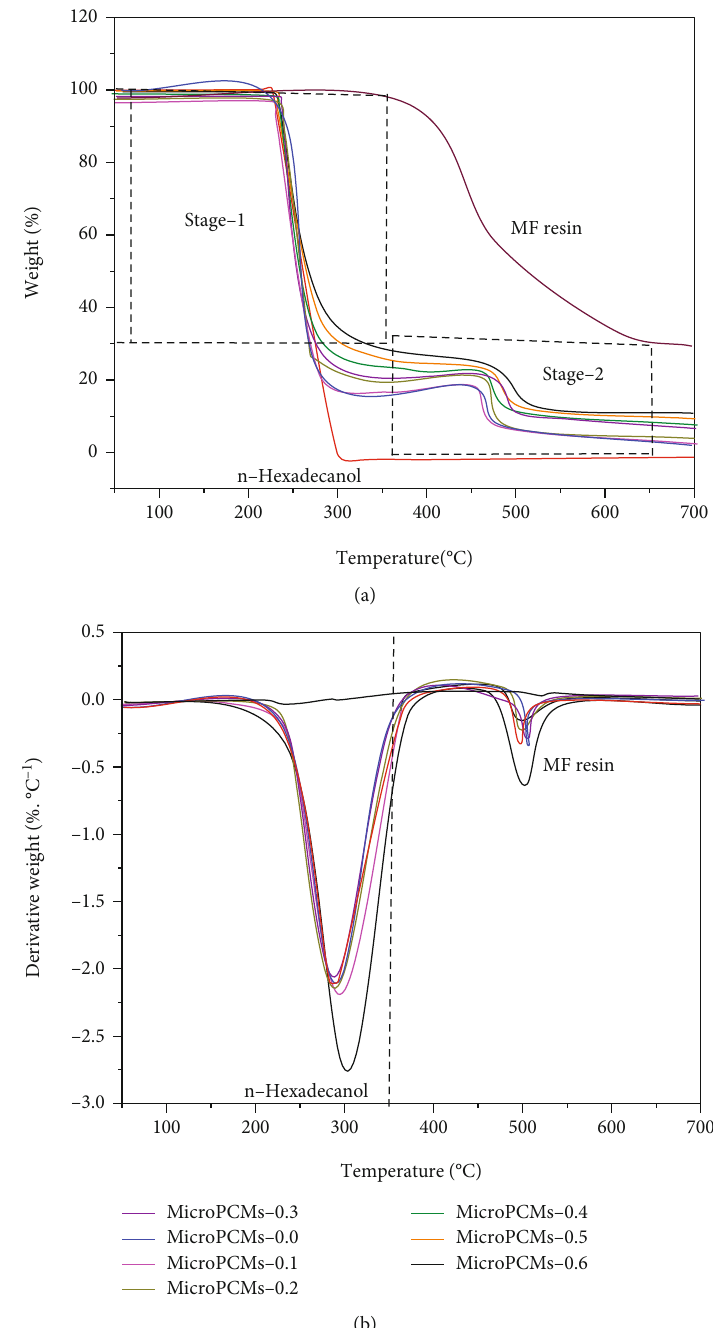
Figure 2: MicroPCMs and n-hexadecanol modi fi ed with various concentrations of HO-CNTs are shown in (a) TGA and (b) DTG